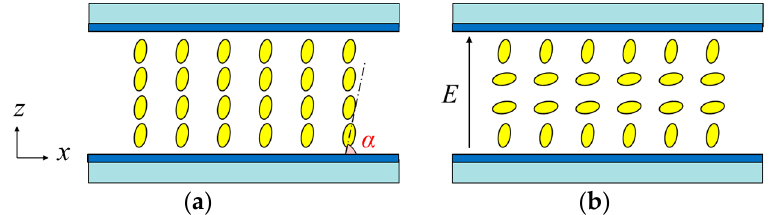
Figure 3. The LC director orientations in VA mode: ( a ) Voltage-off state; ( b ) Voltage-on state.